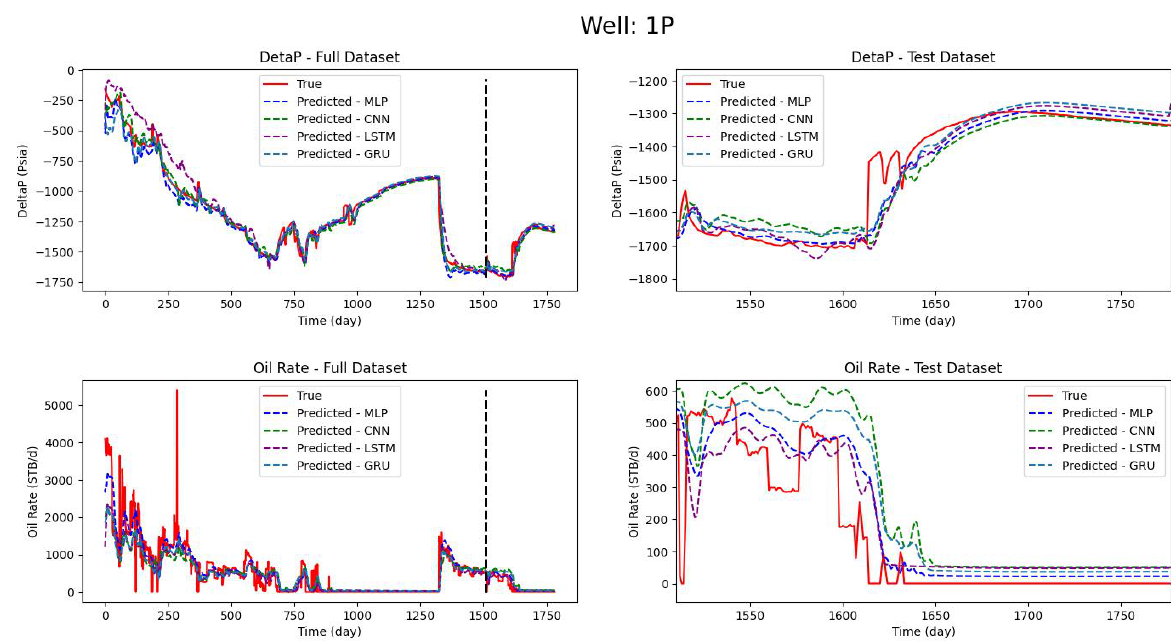
P vs Time - Full Dataset (Top Left); P vs Time - Test